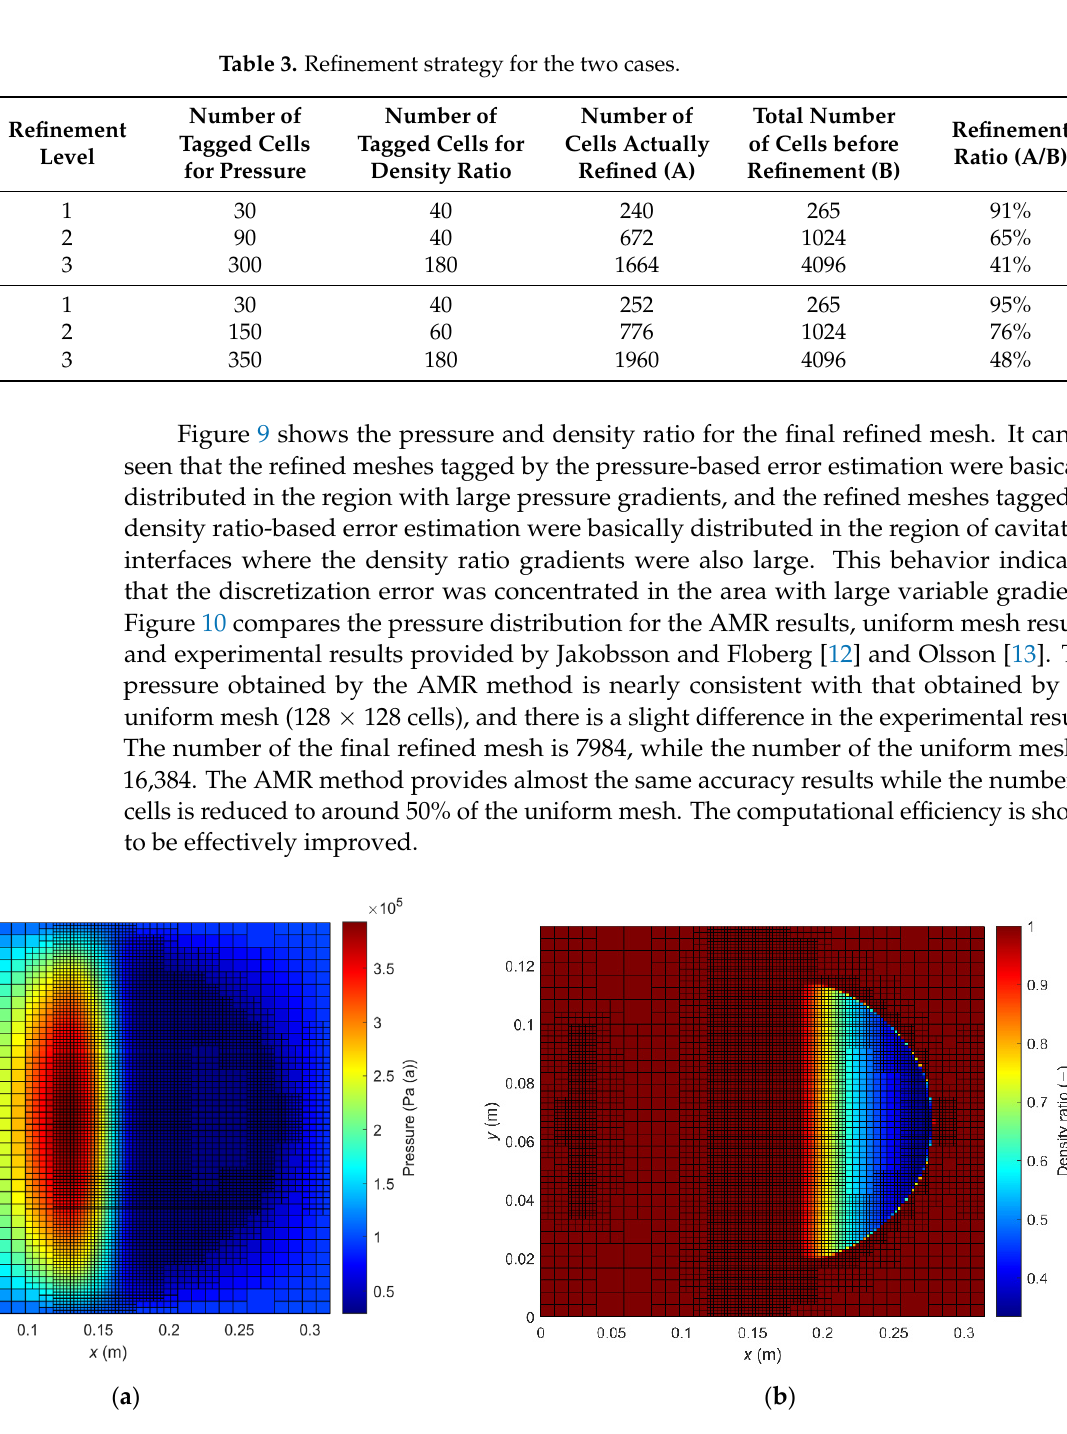
Figure 10. Comparison of pressure distribution between different results for y = 50 mm. The second case is the dimple-enhanced seal-like thrust bearing investigated by Qiu and Khonsari [22]. The bearing surface was textured with duplicated micro circular holes. The variation of the hole height results in a divergence and convergence clearance region. Hence, oil film rupture and reformation simultaneously occur around the hole. The bearing was operated in the condition of r 0 = 750 μ m, h g = 10 μ m, L = 3 mm, h 0 = 4 μ m, μ = 0.0035 Pa·s, U = 1.45 m/s, p c = 0.9 × 10 5 Pa (a), p a = 1.0 × 10 5 Pa (a). The refinement strategy for the bearing is listed in Table 3. The refinement ratios were 91%, 76%, and 48% for the three-time refinements. They are higher than those of case 1. A more computational cost was indicated to be paid. The solution of the three-times refined mesh is compared with the solution of the corresponding uniform mesh and the solution provided by Qiu and Khonsari [22], as shown in Figures 11 and 12. It can be seen that the AMR solution is close to the solution of the uniform mesh (128 × 128 cells) with a small difference compared with the solution provided by Qiu and Khonsari [22]. The difference is mainly reflected by the value of maximum pressure. Ausas’ algorithm is sensitive to the number of grids. Insufficient number of grids often leads to high maximum pressure. The difference is acceptable under the current refinement strategy. The number of the final refined mesh is 9220, which is 56% of the uniform mesh. The AMR method provides almost the same accuracy solution while the computational cost is saved.